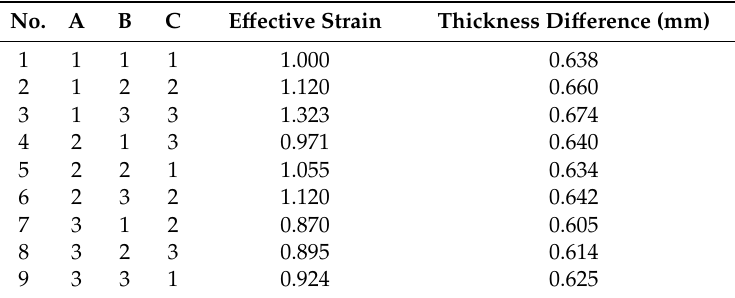
Table 3. Plan of orthogonal experiment and result.